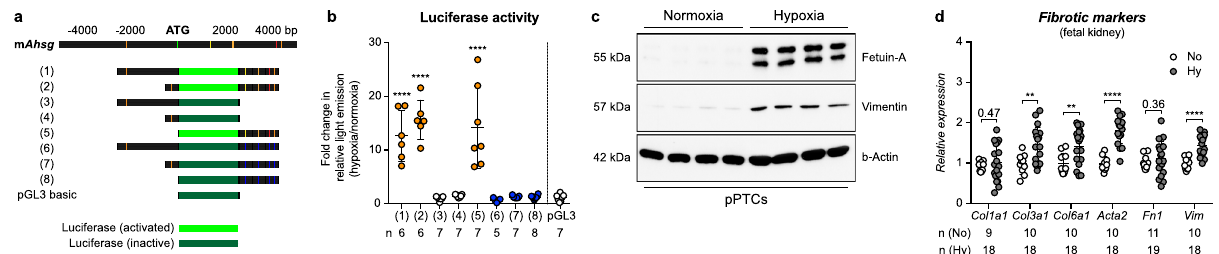
Fig. 4 Hypoxia activates fetuin-A expression in vitro. a Depiction of the potential HREs of mouse Ahsg that were used to generate the luciferase reporter gene constructs (1) to (8). Mutated HREs are shown in blue. b Mean ± SEM of luciferase activity in NRK cells individually transfected with the reporter constructs depicted in a , showing the fold-change in light emission between hypoxic and normoxic culture conditions. Each transfection condition is compared to the empty vector control (pGL3). N = independent experiments. Ordinary one-way ANOVA with Dunnett ’ s multiple comparisons test. c Expression of fetuin-A and vimentin in primary mouse proximal tubular cells (pPTCs) isolated from four different mice cultured under normoxic or hypoxic conditions. Images are representative of two independent Western blots. Uncropped blots in Source Data. d Relative mRNA expression levels of collagens ( Col1a1 , Col3a1 , and Col6a1 ), α -smooth muscle actin ( Acta2 ), fi bronectin ( Fn1 ), and vimentin ( Vim ) in kidneys from normoxic (white circles) or hypoxic fetuses (gray circles). Data is shown as mean ± SEM. N = fetal kidneys. Unpaired 2-sided t -test (with Welch ’ s correction for Col1a1 and Fn1 ). Individual P -values are denoted above the comparison lines. (**** P < 0.0001; ** P < 0.01). Source data are provided as a Source Data fi